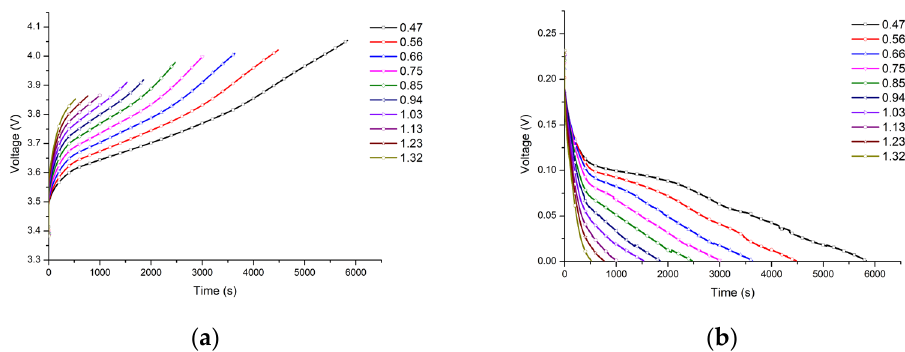
Figure 9. ( a ) Full-cell voltage; ( b ) Anodic half-cell voltage at several C Rates (response versus Li/Li + ).